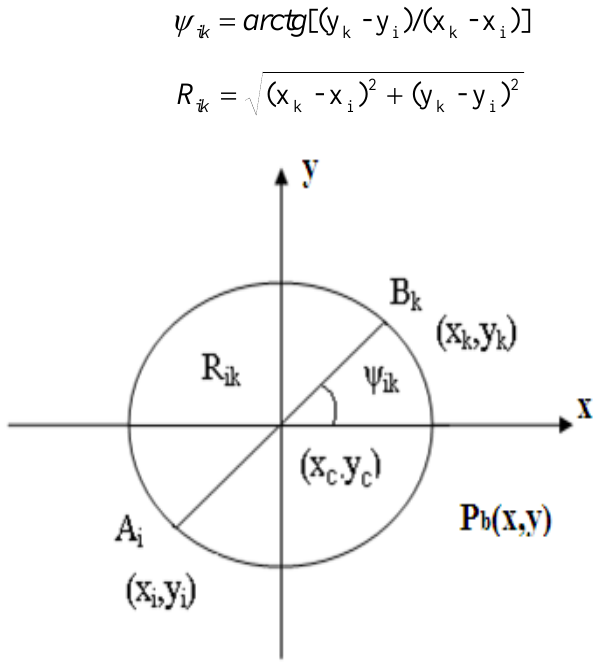
Figure 1 . Central image chords